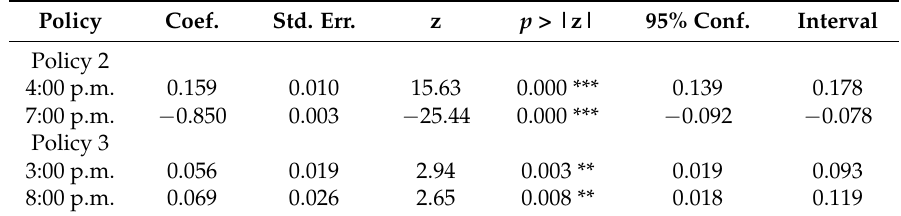
Table 3. Results of the regression discontinuity method of CO concentration on restriction